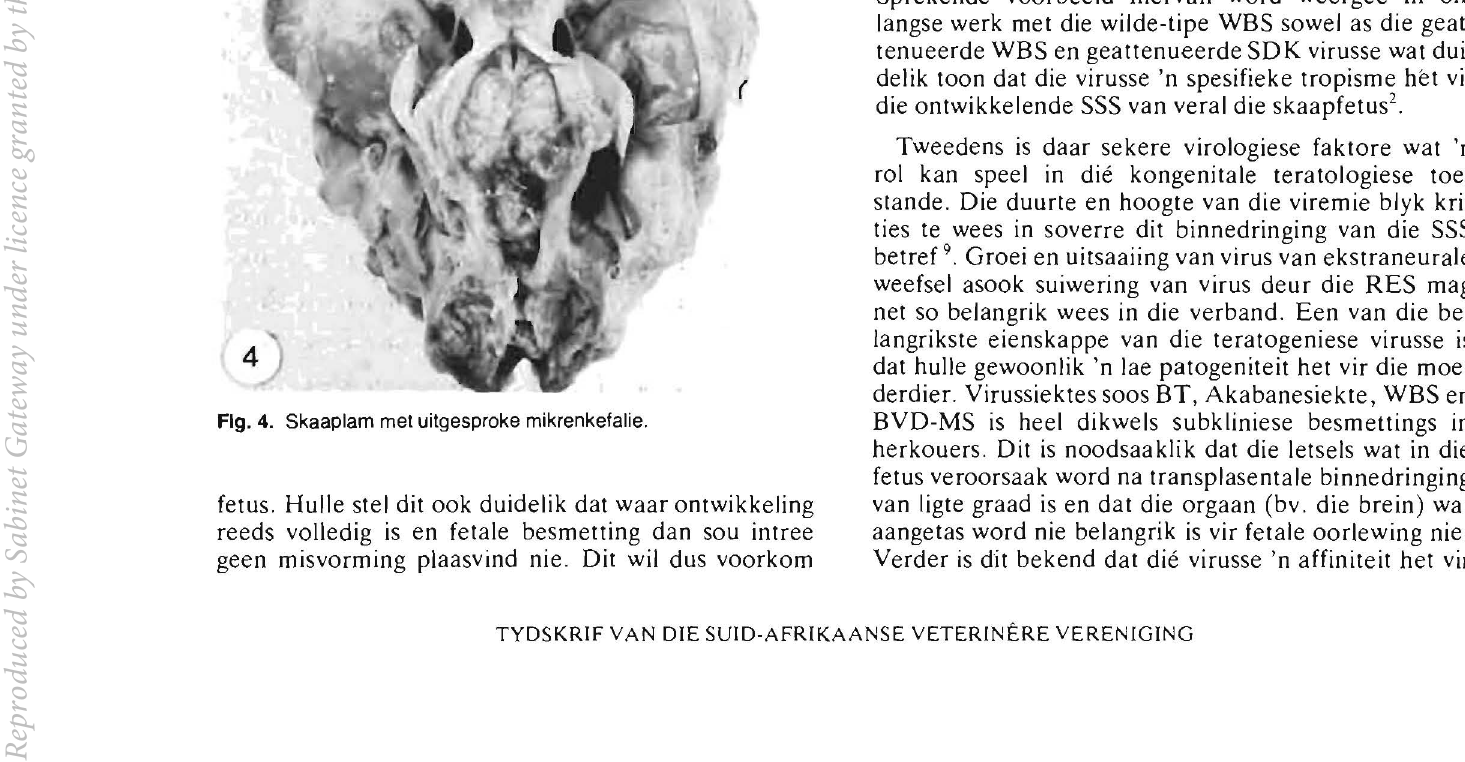
Fig. 4_ Skaaplam met uitgesproke mikrenkefalie.